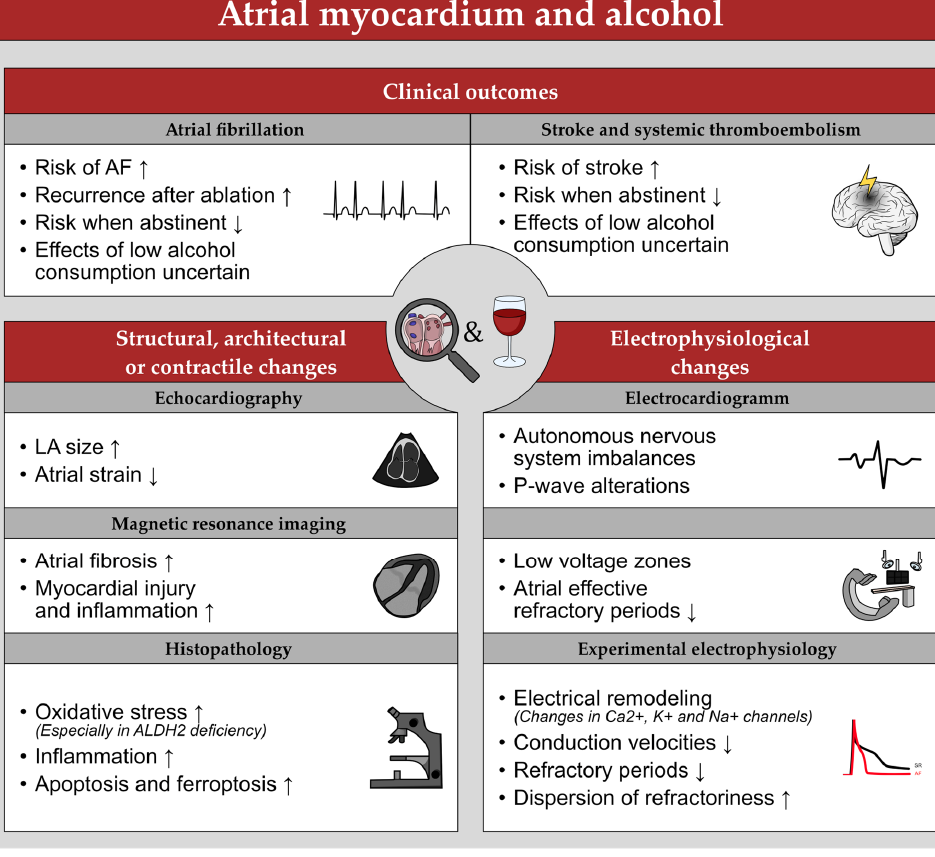
Figure 4. Overview of the impact of alcohol on the atrial myocardium. = indicates no significant changes, ↑ an increase, and ↓ a decrease of the respective